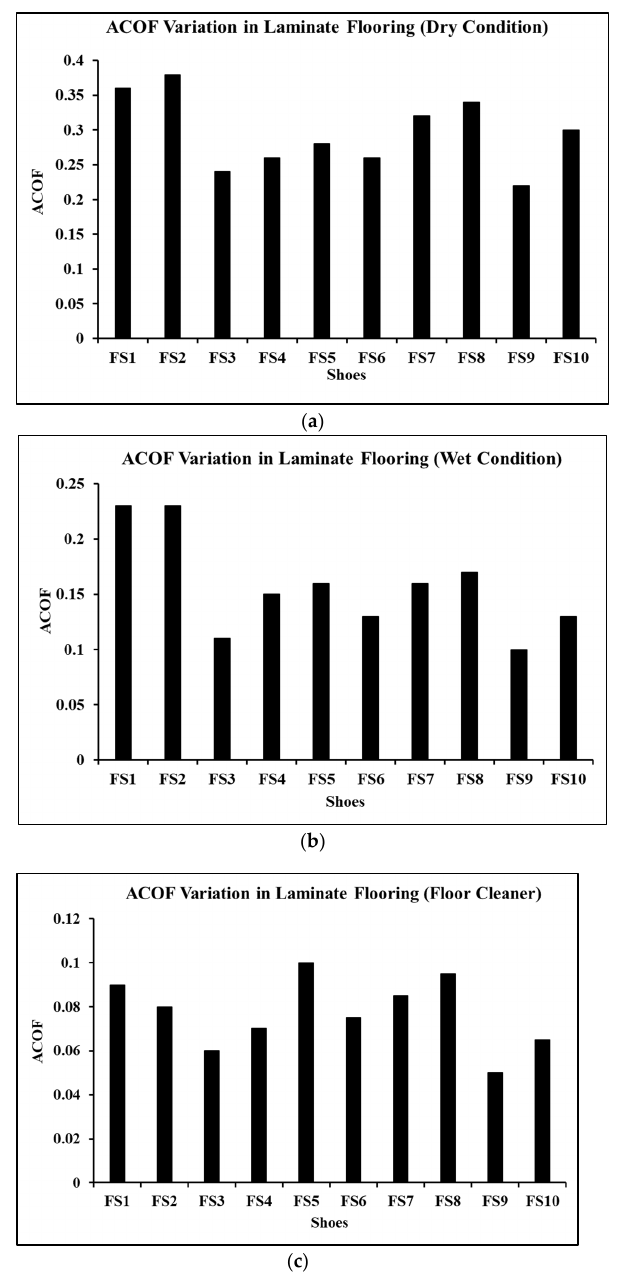
Figure 4. Traction performance of shoes on laminate flooring in: ( a ) dry condition, ( b ) water ‐ con ‐ taminated condition, and ( c ) floor ‐ cleaner ‐ contaminated